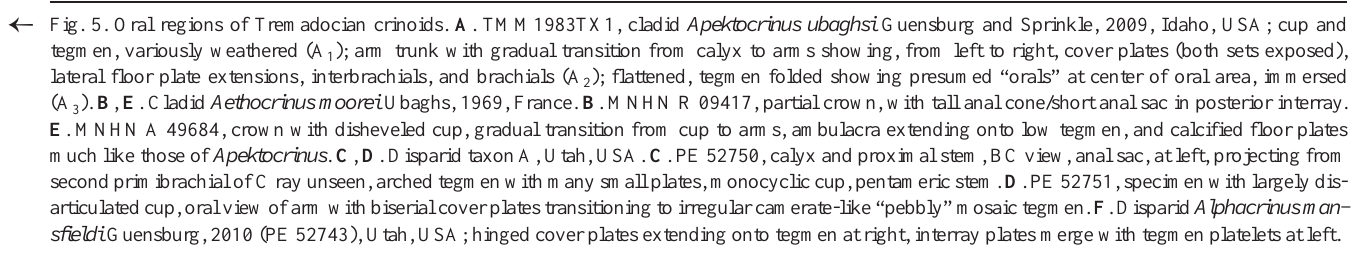
Fig. 5. Oral regions of Tremadocian crinoids. A . TMM1983TX1, cladid Apektocrinus ubaghsi Guensburg and Sprinkle, 2009, Idaho, USA; cup and tegmen, variously weathered (A 1 ); arm trunk with gradual transition from calyx to arms showing, from left to right, cover plates (both sets exposed), lateral floor plate extensions, interbrachials, and brachials (A 2 ); flattened, tegmen folded showing presumed “orals” at center of oral area, immersed (A 3 ). B , E . Cladid Aethocrinus moorei Ubaghs, 1969, France. B . MNHN R 09417, partial crown, with tall anal cone/short anal sac in posterior interray. E . MNHN A 49684, crown with disheveled cup, gradual transition from cup to arms, ambulacra extending onto low tegmen, and calcified floor plates much like those of Apektocrinus . C , D . Disparid taxon A, Utah, USA. C . PE 52750, calyx and proximal stem, BC view, anal sac, at left, projecting from second primibrachial of C ray unseen, arched tegmen with many small plates, monocyclic cup, pentameric stem. D . PE 52751, specimen with largely dis- articulated cup, oral view of arm with biserial cover plates transitioning to irregular camerate-like “pebbly” mosaic tegmen. F . Disparid Alphacrinus man- sfieldi Guensburg, 2010 (PE 52743), Utah, USA; hinged cover plates extending onto tegmen at right, interray plates merge with tegmen platelets at